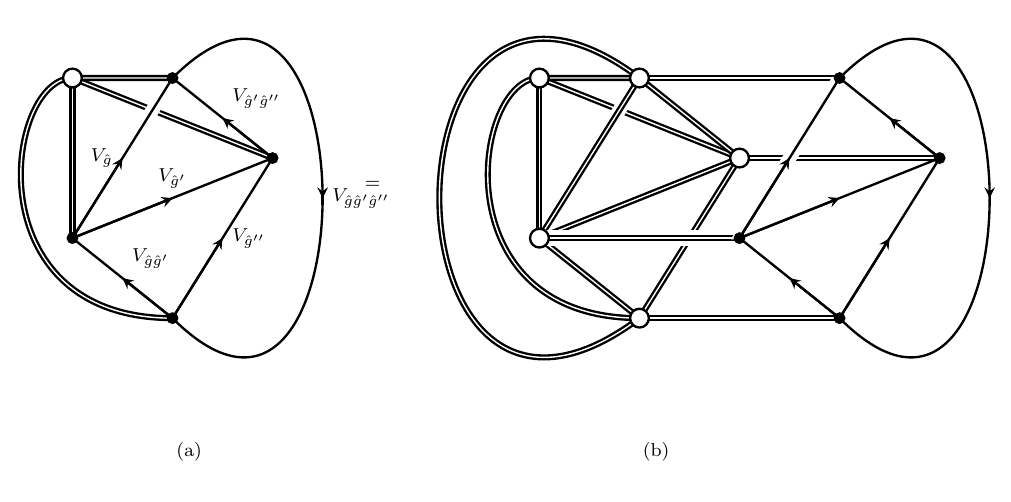
Figure 35 . The computation of the tetrahedron contribution for the ^ G Gu-Wen phase decorated by an extra 2-form (cid:13)at connection (cid:12) 2 .